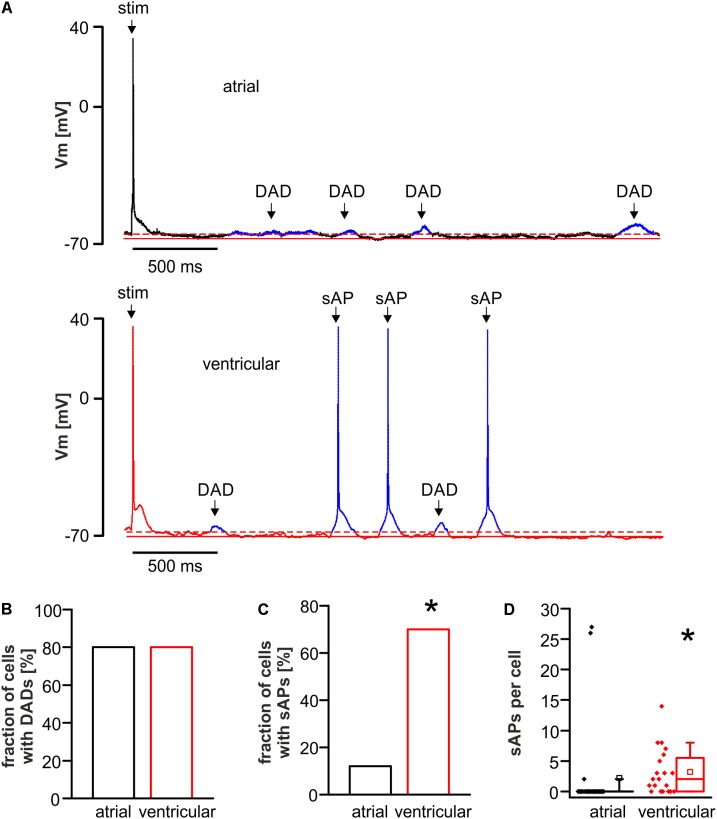
DADs and spontaneous action potentials (sAPs) in atrial and ventricular cardiomyocytes. (A) Representative tracings with a stimulated action potential (stim) of atrial (upper panel) and ventricular (lower panel) myocytes exhibiting DADs in the resting period. Ventricular cells did also exhibit translation of DADs into sAPs. While the fraction of cells with DADs was unaltered (B), the fraction of cells with sAPs (C) and the average number of sAPs per cell (D) was increased in ventricular compared to atrial myocytes. ∗p < 0.05 atrial vs. ventricular.